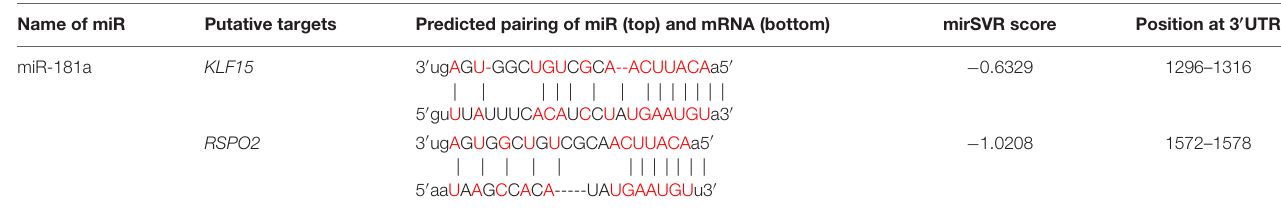
TABLE 1 | In silico analysis for annealing efficiencies between putative mRNA targets and miR-181a. Name of